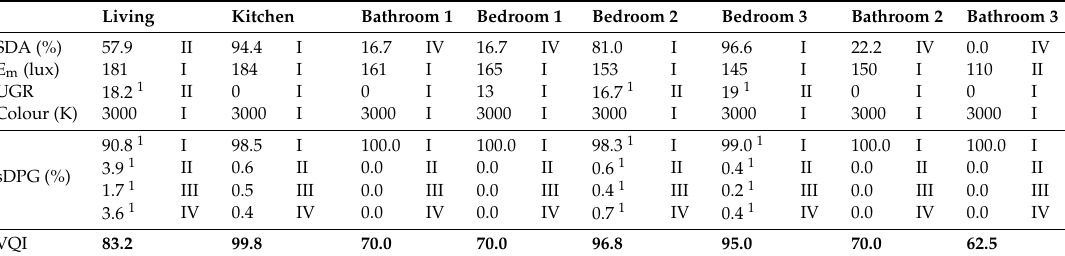
Table 9. Visual quality indexes (VQIs) of all the rooms.